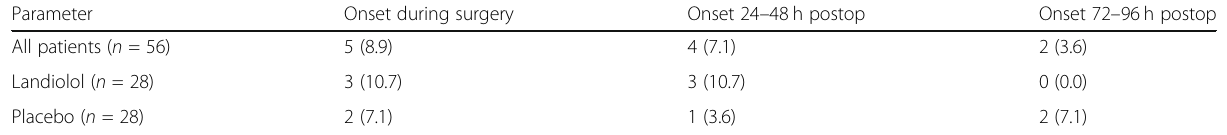
Table 4 Time of atrial fibrillation onset, starting from 9:00 AM on the day of surgery Parameter Onset during surgery Onset 24 – 48 h postop